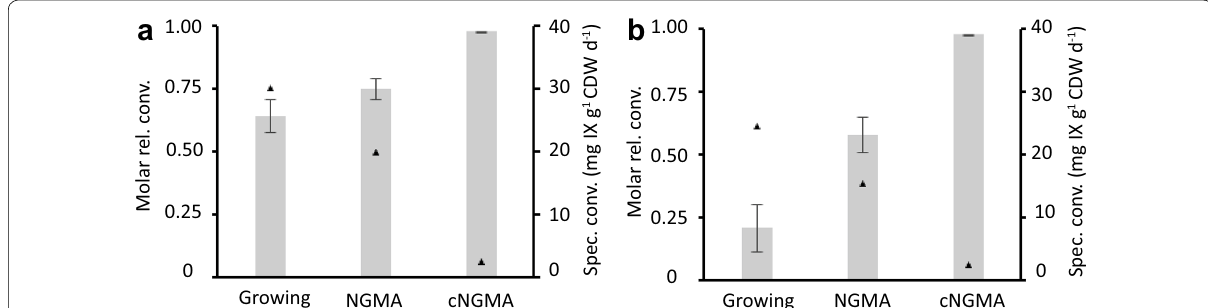
Fig. 4 Conversion of 35 mg IX L − 1 by Eubacterium limosum at the maximal pH for growth of 7.5–7.7 for IX (n spent hop-IX ( b ). Bars indicate molar relative conversion, triangles indicate specific conversion for the growing biomass, non-growing metabolically active (NGMA) cells and 10 concentrated NGMA ×